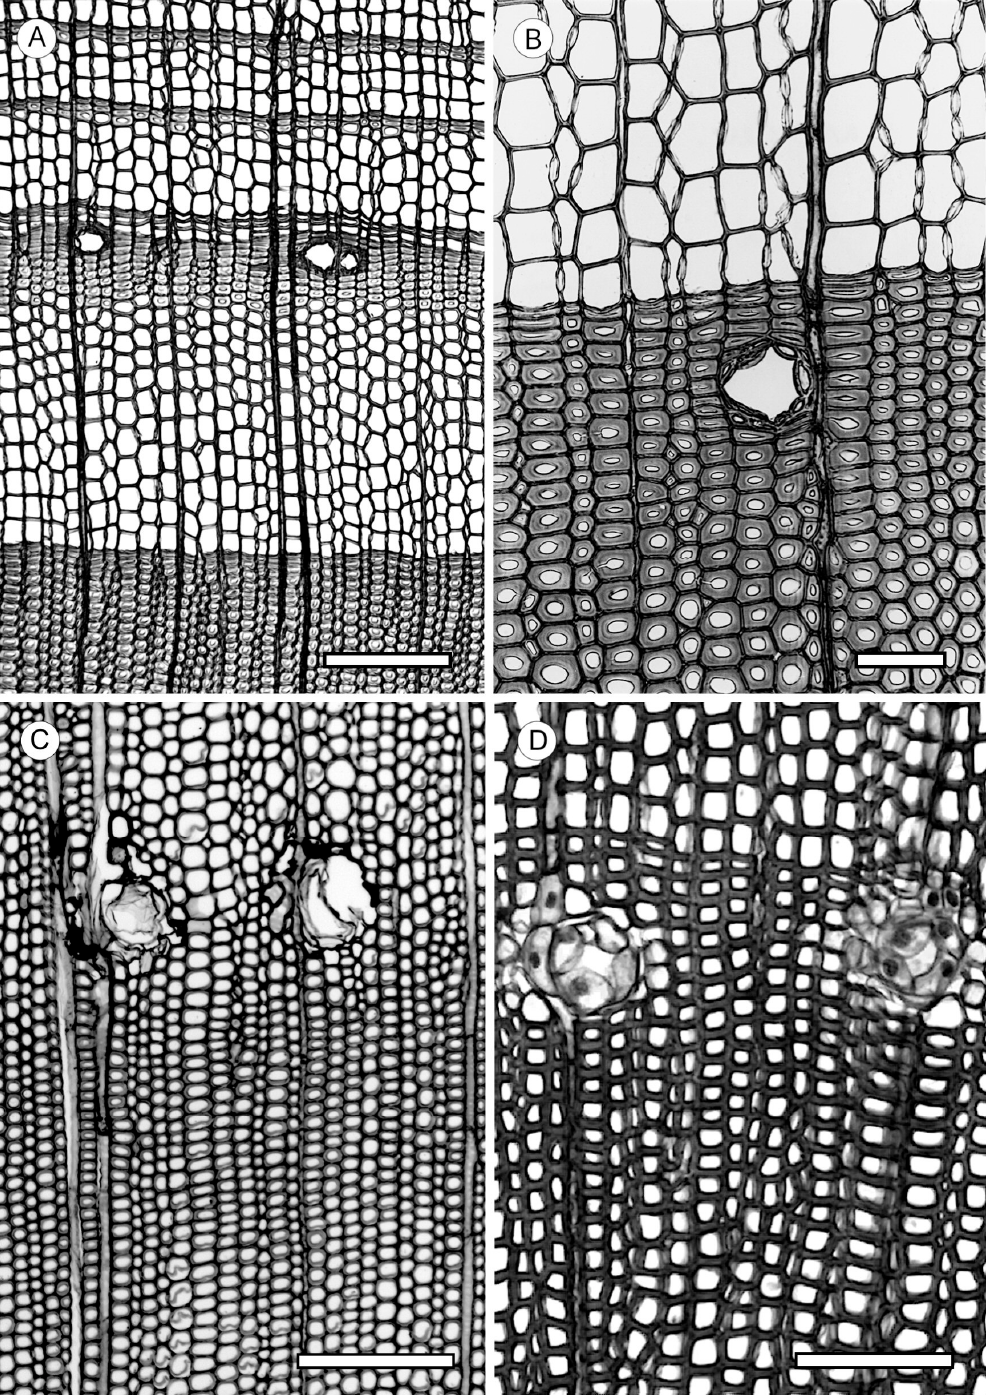
Figure 39. Normal axial resin canals. ( A , B ) Thick-walled epithelial cells in axial resin canals of Larix decidua Mill.; ( C ) Thin-walled epithelial cells in axial resin canals of Pinus radiata D.Don. and ( D ) Thin-walled epithelial cells in axial resin canals of Pinus sylvestris L. Scale bars. ( A ) = 500 μ m; ( B ) = 100 μ m; ( C ) = 200 μ m, ( D ) = 100 μ m.